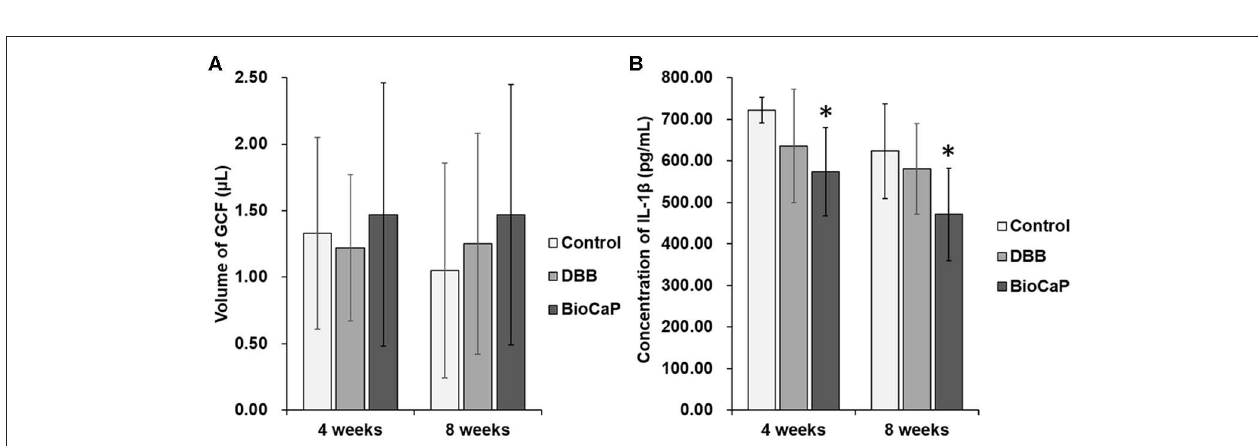
FIGURE 6 | The distances of OTM were less in Bio-CaP group compared to other groups. (A) The mean accumulated distance of OTM at 8 weeks, (B) Rate of OTM at 2 weeks interval. Data are from six independent experiments.